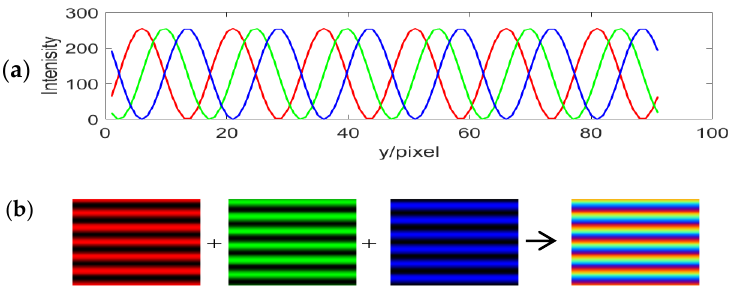
Figure 2. The quadrature phase-shifting color composite grating: ( a ) intensity distribution of tri- color channels of the color composite grating pattern; and ( b ) the encoding process of the color composite grating pattern.